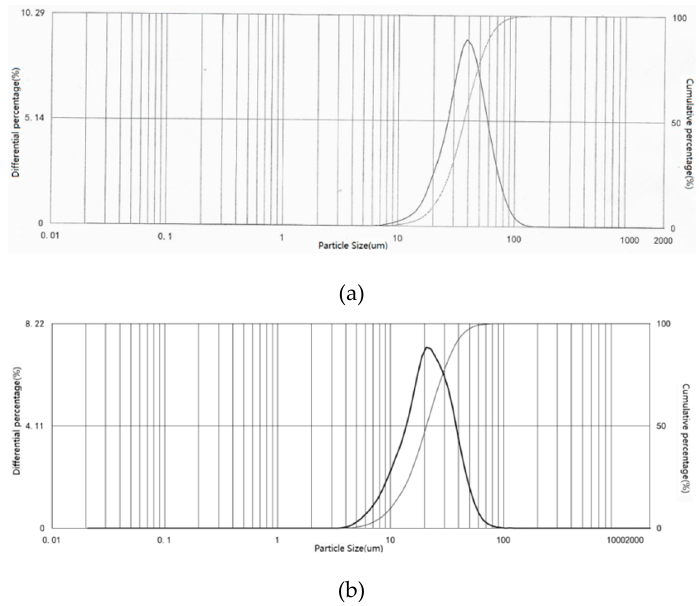
Figure 12. Spray particle size distribution test results with different nozzles. ( a ) Spray particle size distribution results of 3750 mL / h (Original Nozzle: SMD = 39.5 um); and ( b ) Spray particle size distribution results of 3750 mL / h (Optimized Nozzle: SMD = 35.2 um).